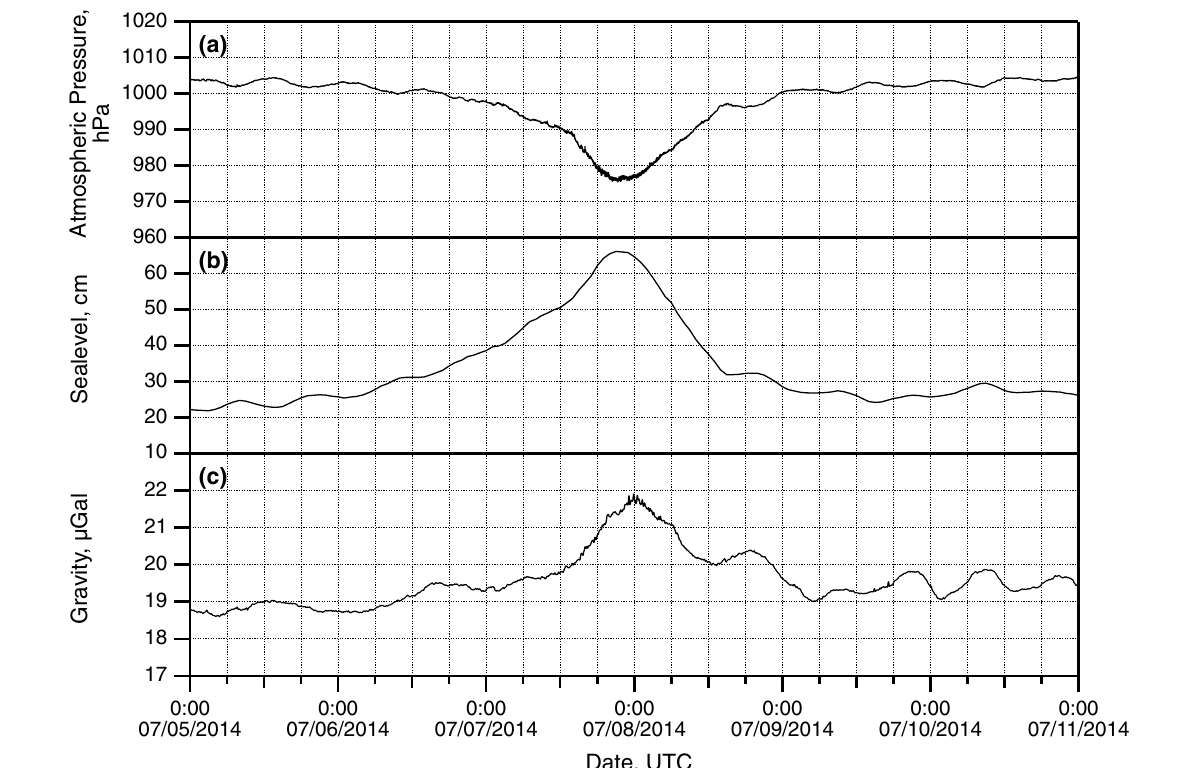
Fig. 7 Time series data recorded during the period when the typhoon Neoguri approached Ishigakijima island. a Atmospheric pressure. b